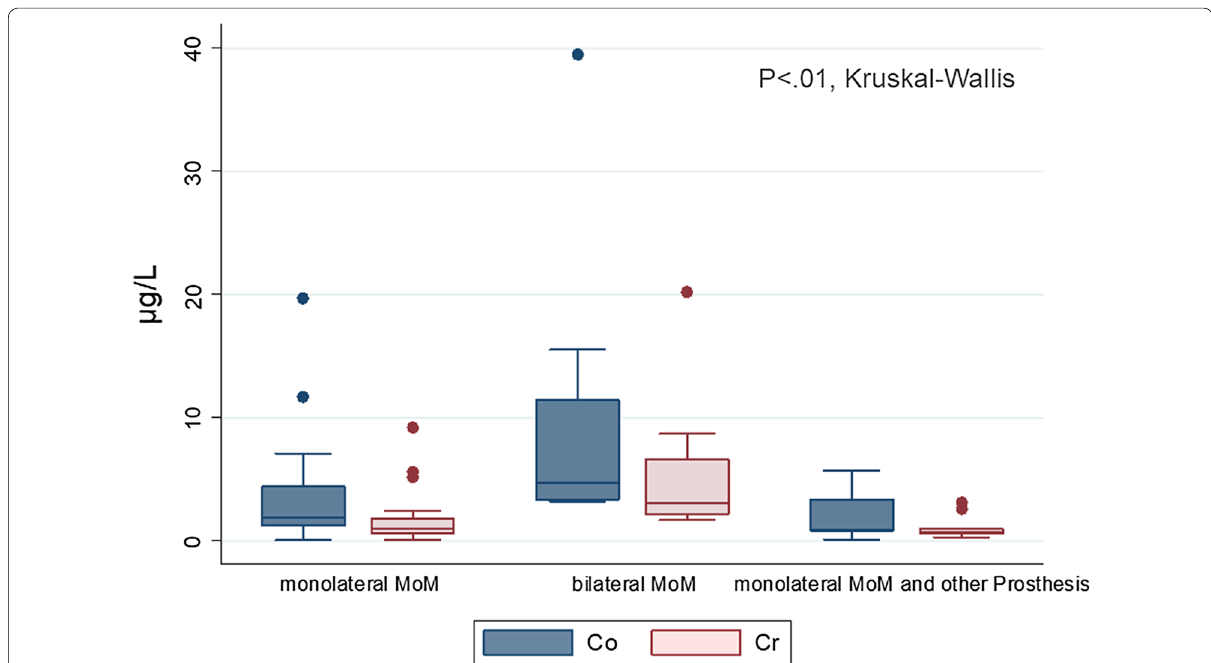
Fig. 3 Box plots showing the whole blood levels of metal ions for cobalt (Co) and chromium (Cr) relative to the groups with monolateral MoM, bilateral MoM or monolaterale MoM with another hip or knee prosthesis. The boxes represent the median and interquartile range (IQR) and whiskers denote the range of data excluding outliers. Co and Cr levels were significantly higher in bilateral MoM ( p < 0.01,